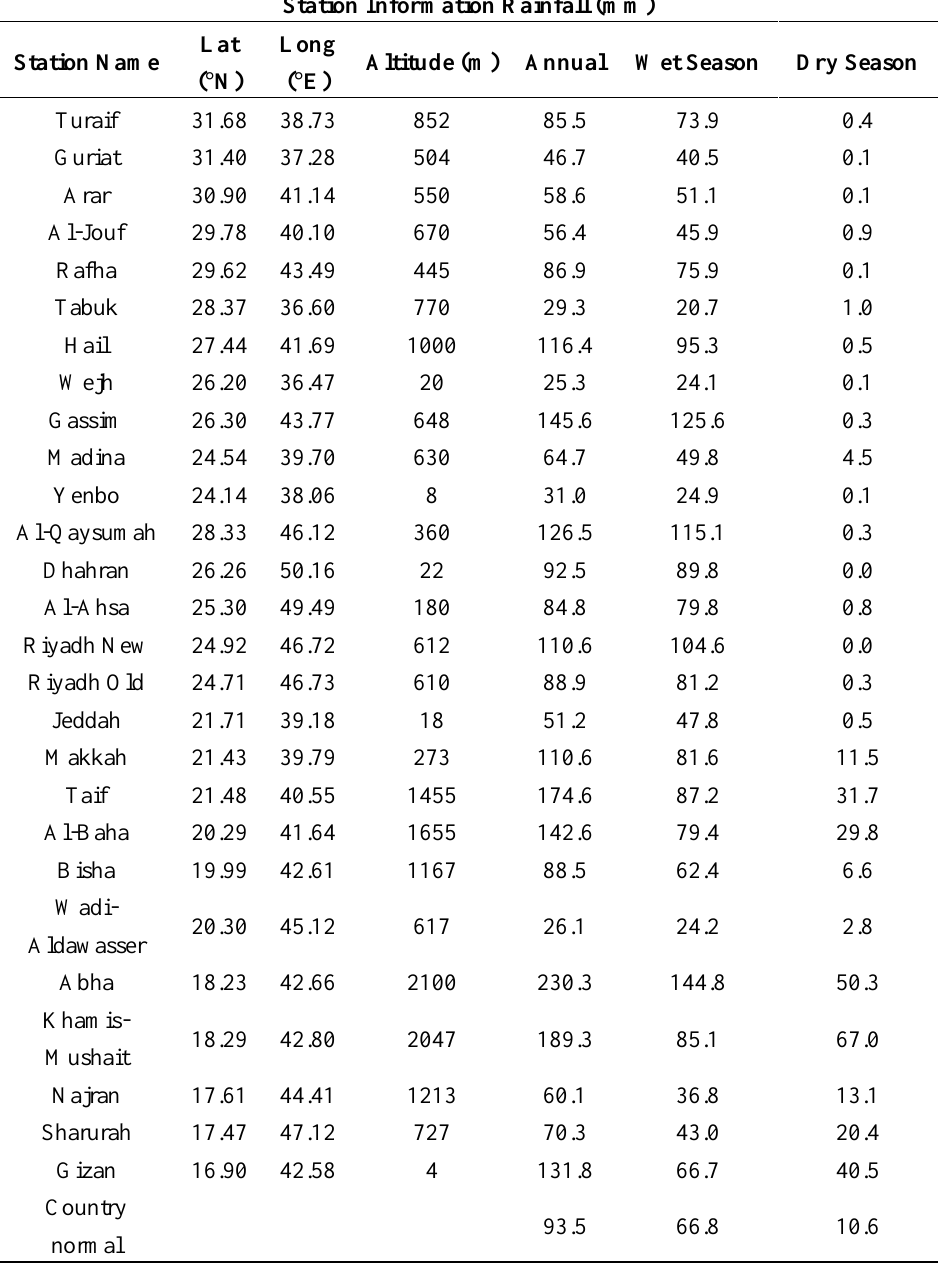
Table 1. The surface observation station information and the corresponding rainfall amounts (mm) over Saudi Arabia during the period 1979–2009. The wet season is November to April and the dry season is June to September. In the first column, the asterisk (*) after the station name indicates that the dataset is available from 1985. The last row provides the national average rainfall values averaged over all the stations